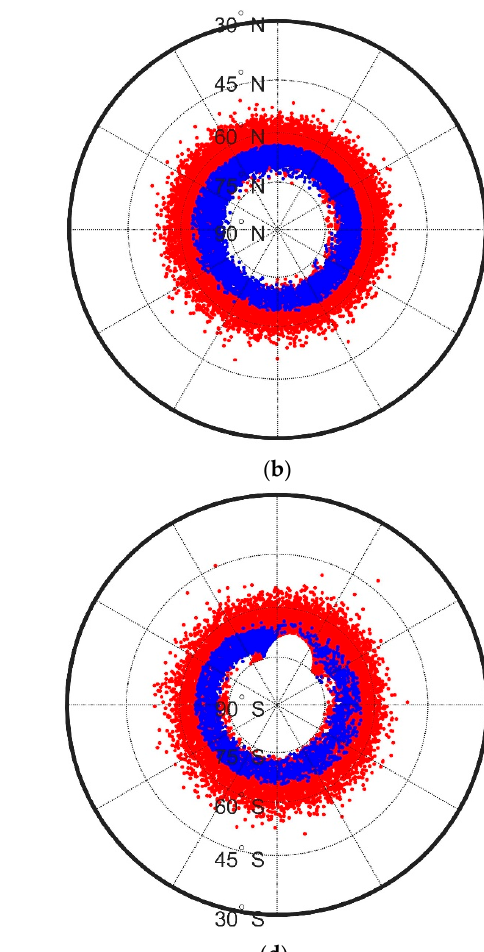
Figure 1. Auroral boundary for the northern ( a , b ) and southern ( c , d ) hemispheres in geographic ( a , c ) and geomagnetic corrected coordinates ( b , d ) for 1990 considering the dataset with QC = 1 and 2 and 0 ≤ Kp ≤ 2 (blue dots); and QC = 1, 2, and 3 and all Kp values (blue + red dots).